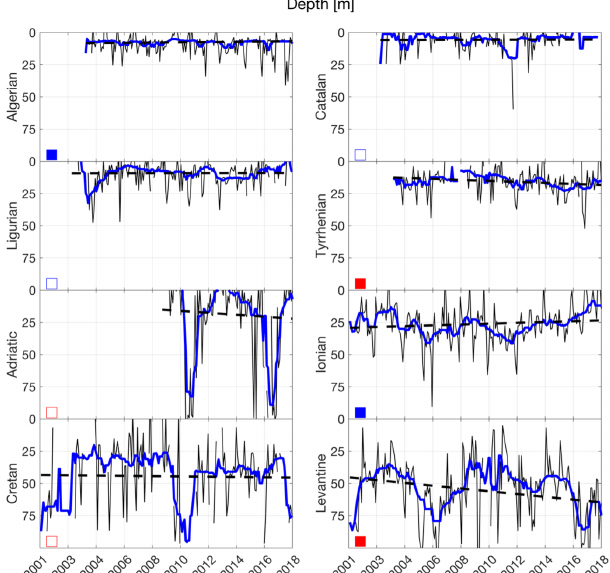
Figure 5. The same as Fig. 3 but for the AW depth. Positive and neg- ative trends (red and blue squares, respectively) in this case corre- spond to an increase or decrease in depth (i.e. deeper or shallower),